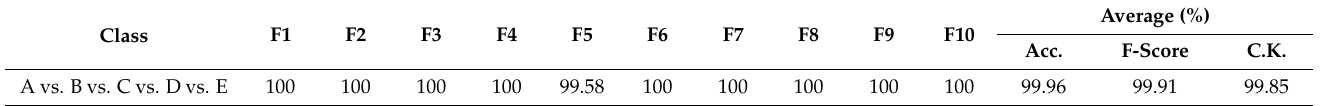
Table 5. Performance result of five-class with 10-fold CV, here Fi means ith fold, and all result are in (%).